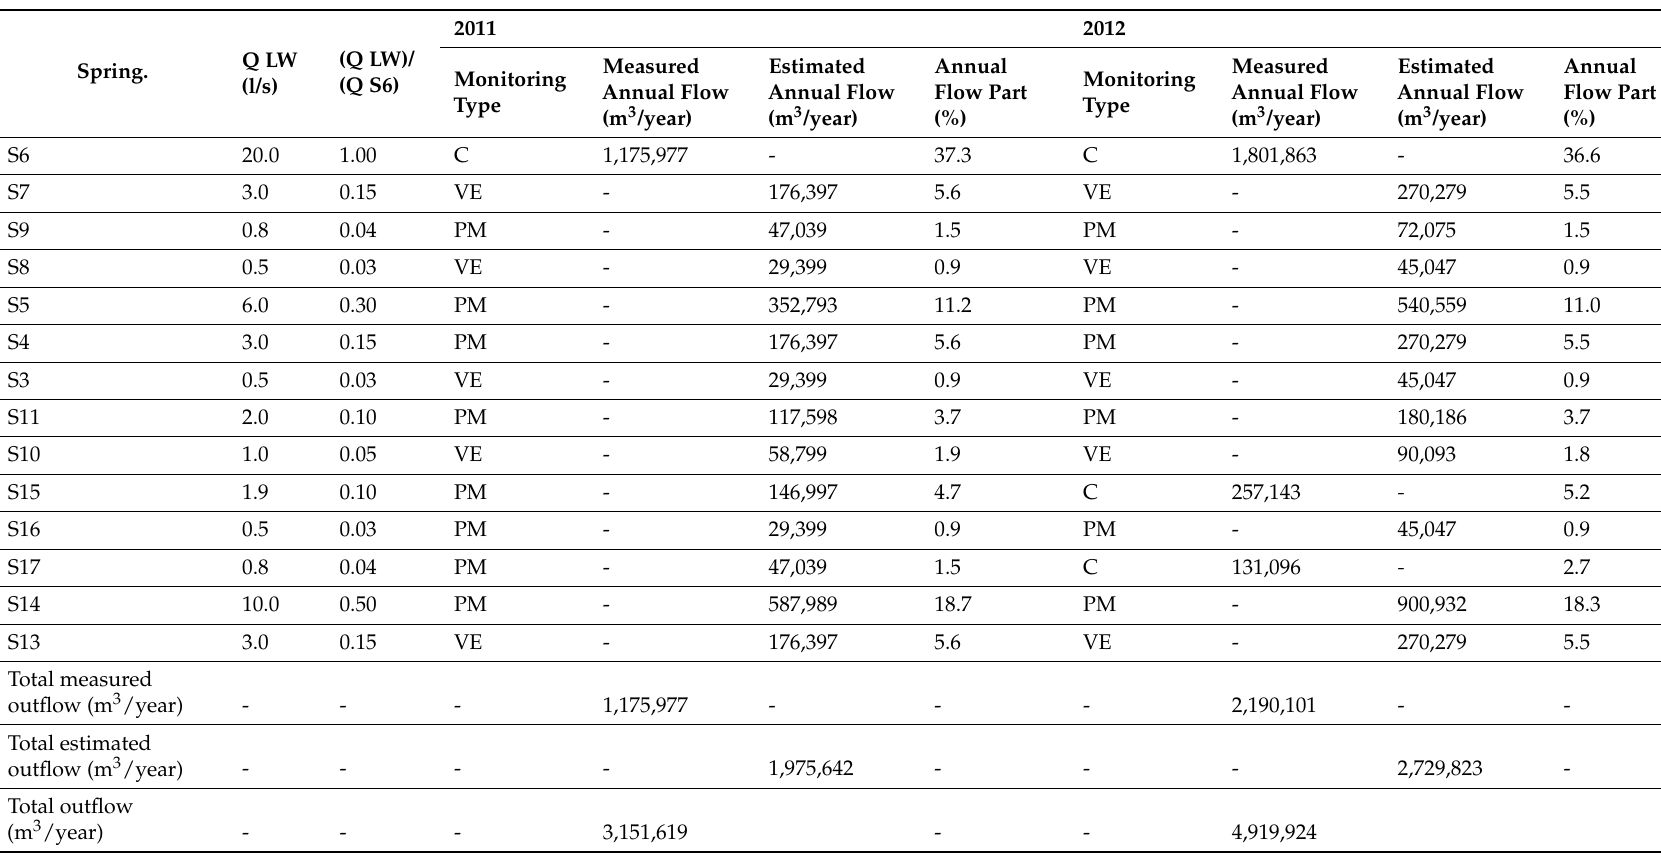
Table 1. Calculated outflow from the Grand Ilet breccia aquifer (C: Continuous monitoring; PM: One-off measurement; VE: Visual estimate). Q LW corresponds to low-water spring